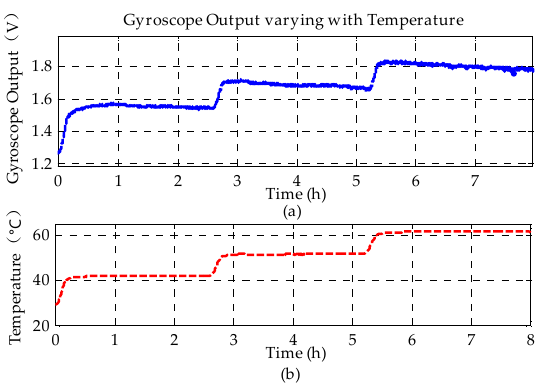
Figure 12. ( a ) Gyroscope output along h -axis and ( b ) temperature response varying with time.